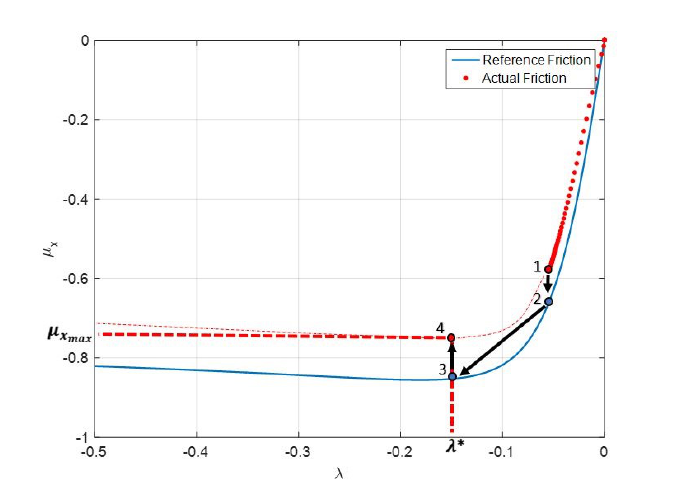
Figure 4. Procedure to evaluate potential friction